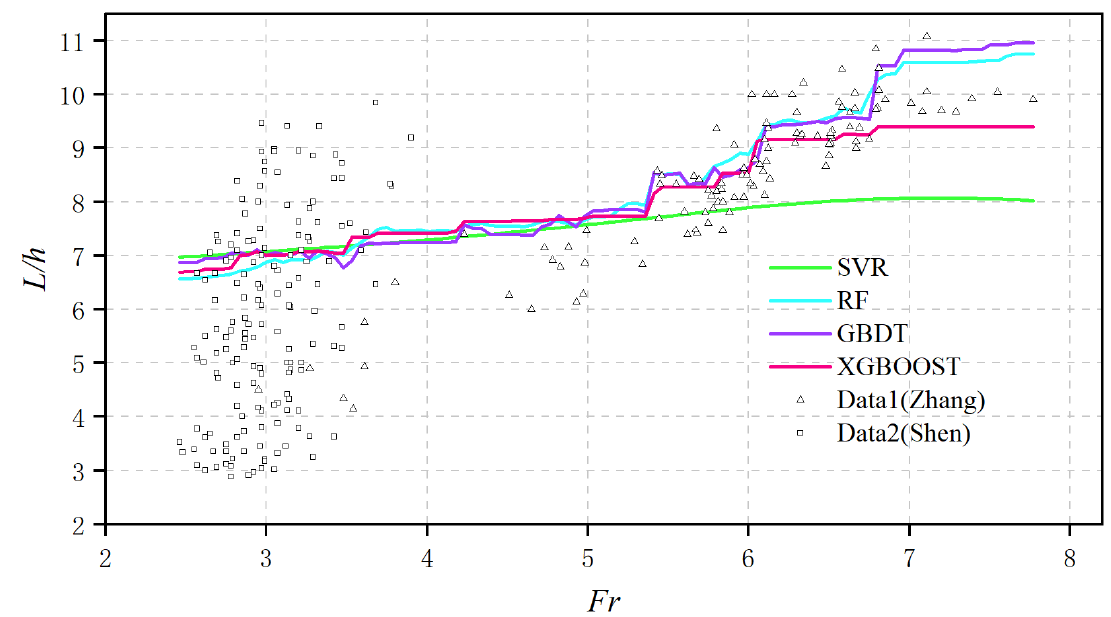
Figure 7. Prediction of L/h with respect to Fr using different ML